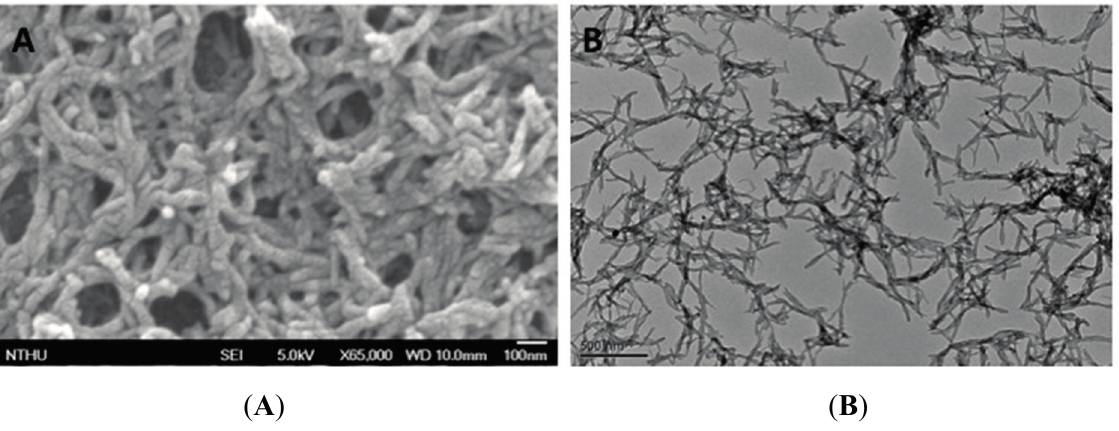
Figure 5. SEM (Scale bar 100 nm, A ) and TEM images (Scale bar 500 nm, B ) of PANI-Nap